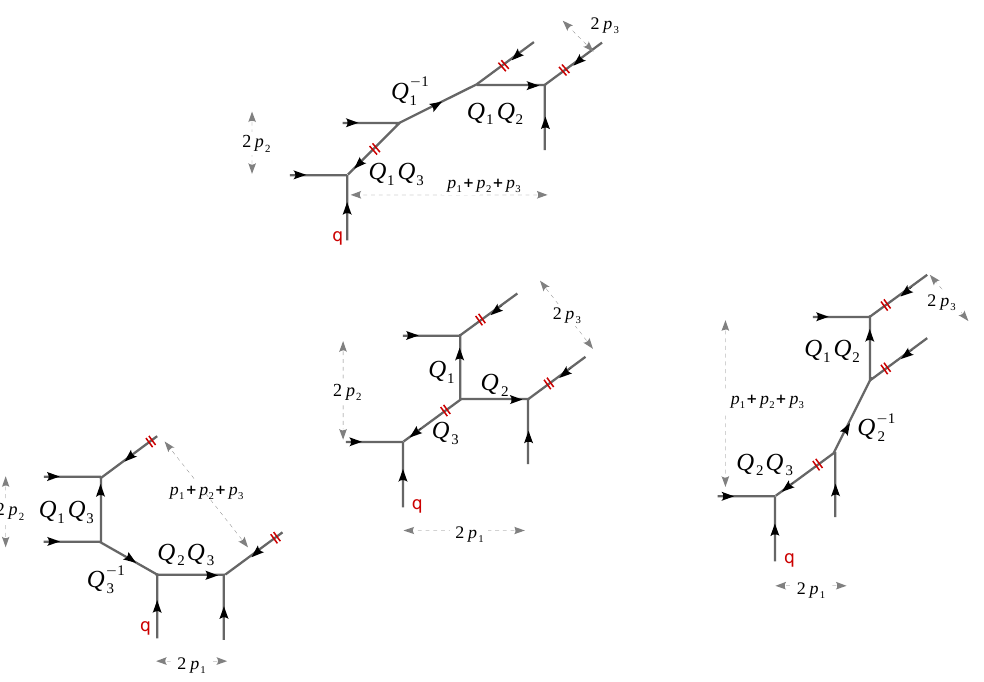
Figure 8 . Di(cid:11)erent T 2 diagrams related by